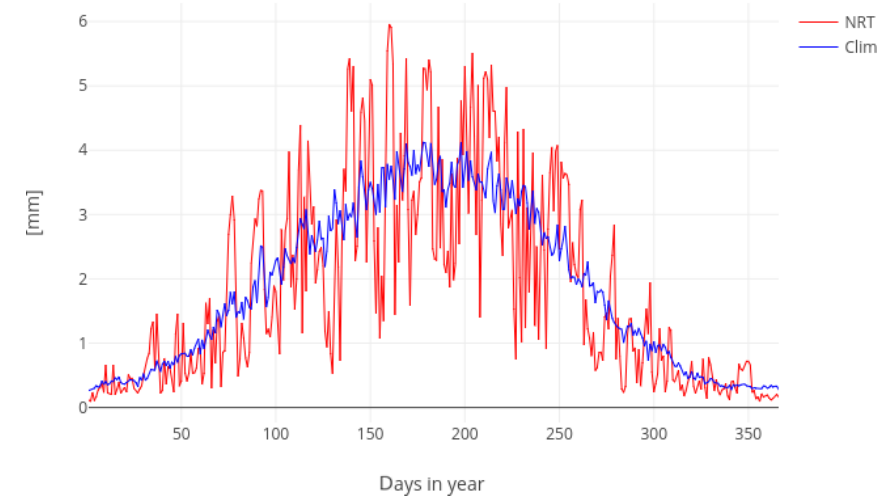
Figure 2. Difference between climatology and near-real-time potential evaporation. Shown for the year 2004 for grid cell x : 200, y : 200.